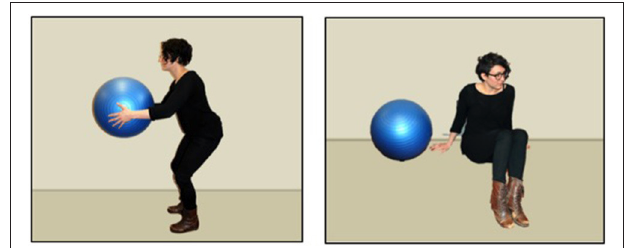
FIGURE 1 | Still images from the test scenes from one trial, depicting an animate agent (the girl) and inanimate patient (the ball). Mandarin-speaking participants viewed videos of Chinese actors performing these same actions.